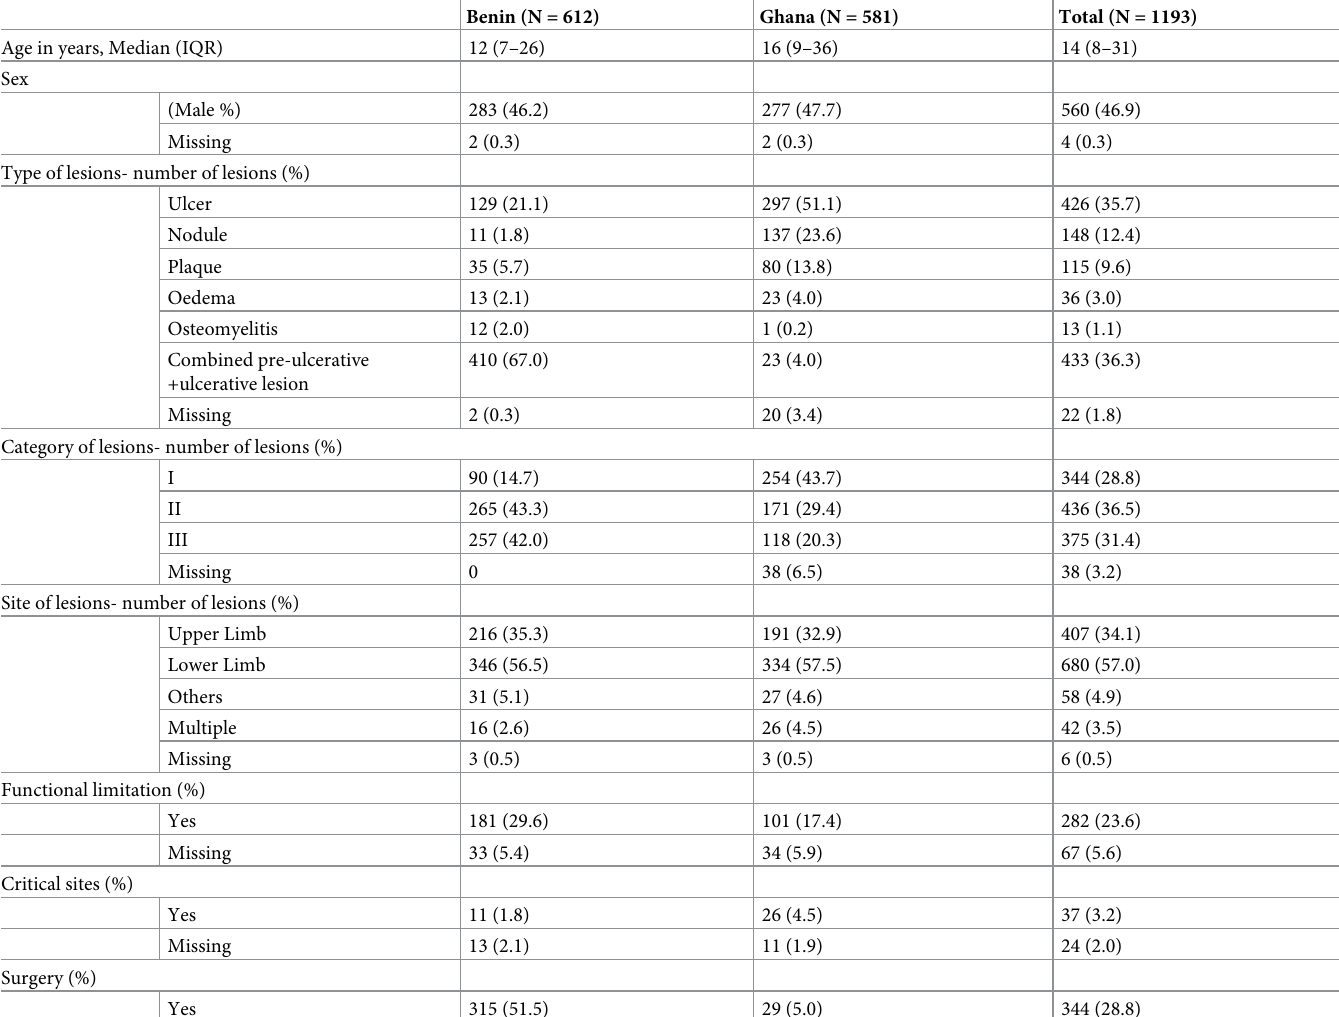
Table 1. Characteristics of patients included in the